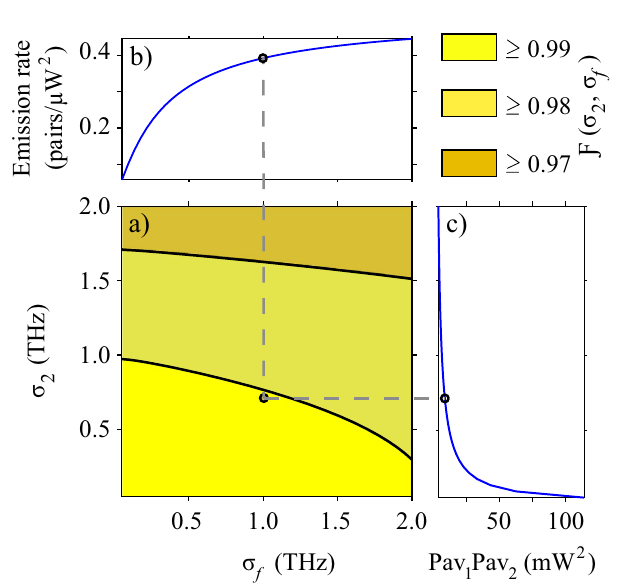
Figure 5. Methodology for increasing the qubit preparation fidelity. Single-qubit preparation fidelity in terms of the length of the DFG waveguide ( L ), the bandwidth of pump 1 ( σ 1 ), and the length ( l c ) and reflectivity ( R i ) 4 THz. The black circle marker indicates the combination of 0.5 THz and σ of the SFWM cavity, for σ 2 f = = parameters we choose for our example.